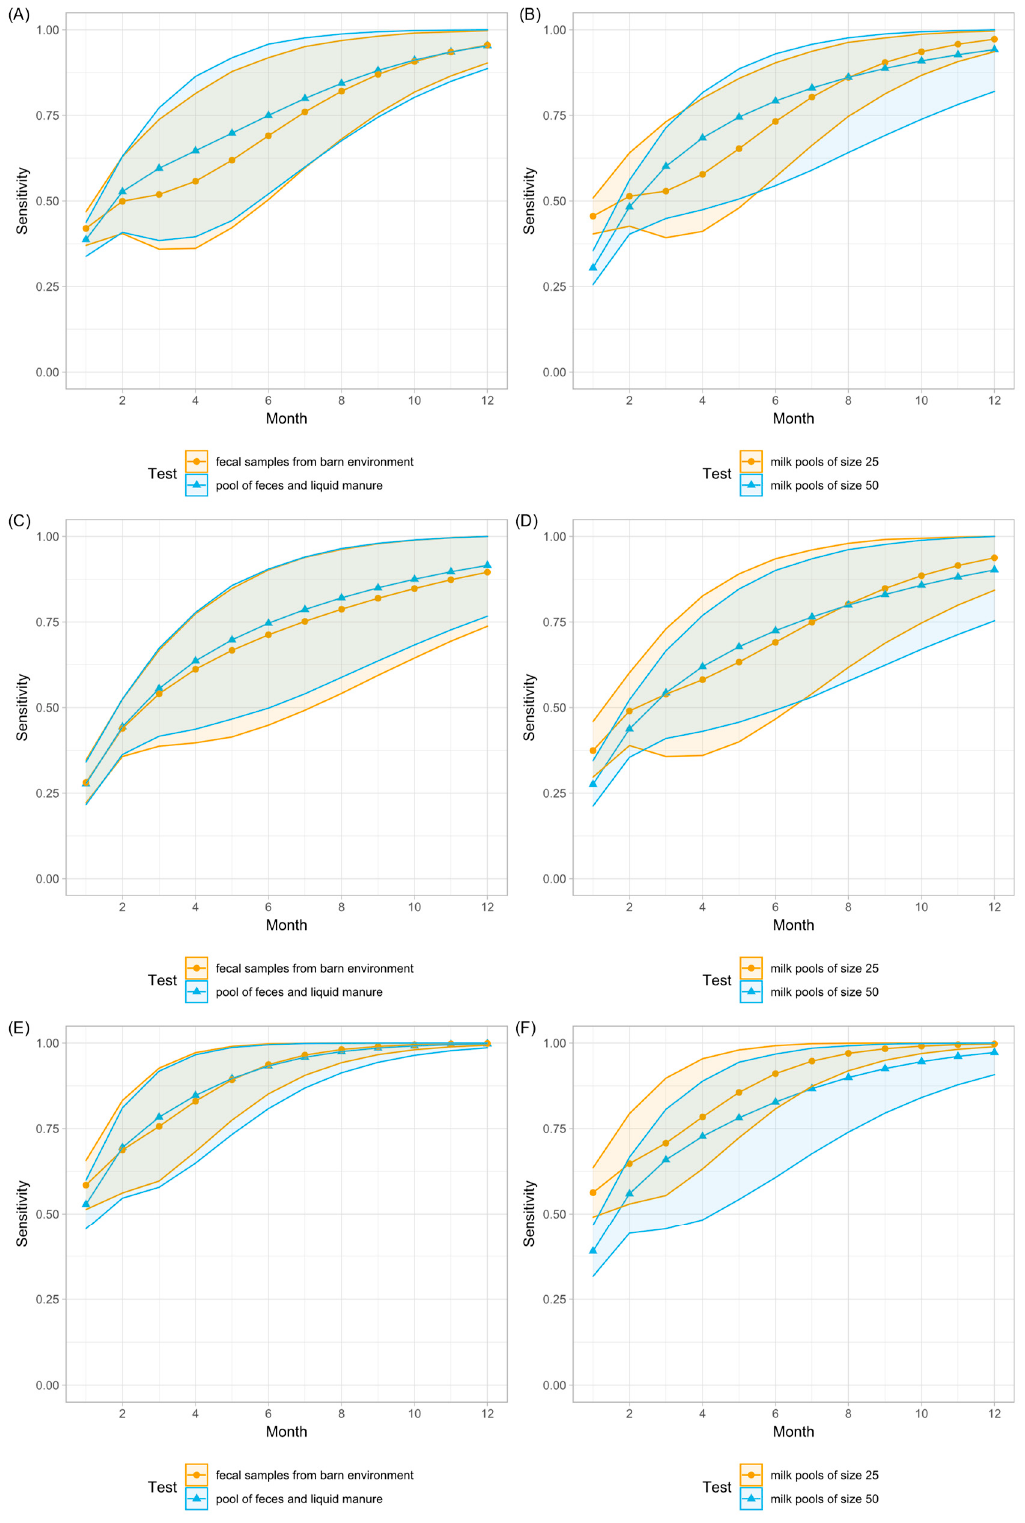
Figure 2. Cumulative sensitivity and 95% CI of environmental samples and pooled milk samples from large low-prevalence dairy herds for the detection of MAP. ( A , B ) Model run with the data of all study herds. ( C , D ) Model run with the data of all MAP non-suspect herds (group 0) and all MAP-infected herds with a within-herd prevalence of MAP-shedders of less than 2% (group 1). ( E , F ) Model run with the data of all MAP non-suspect herds (group 0) and all MAP-infected herds with a within-herd prevalence of MAP-shedders of at least 2% (group 2).